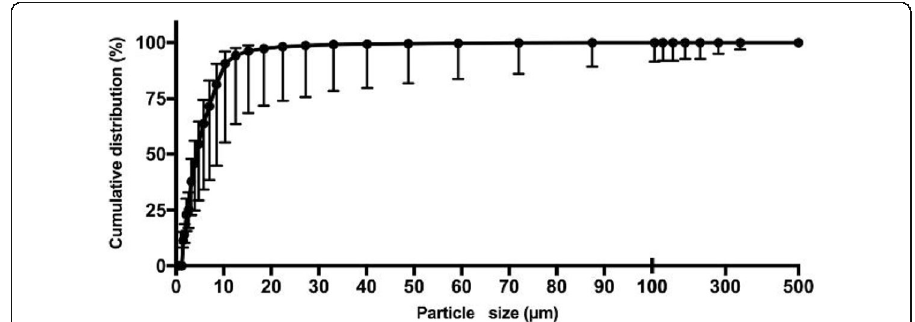
Fig. 3 Cumulative distribution of particle size. Data is presented as means with standard